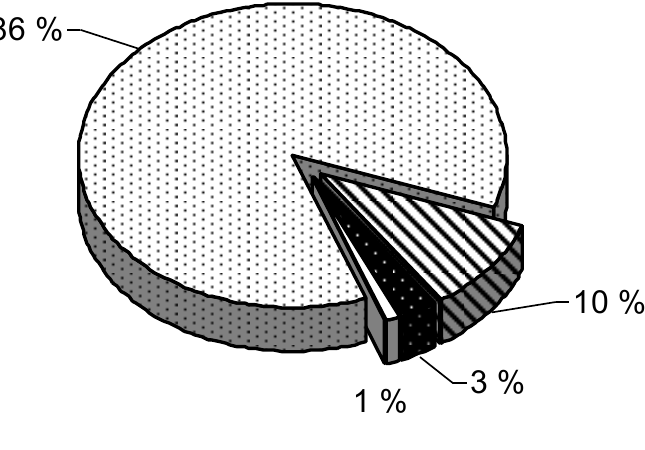
Fig.3. Importance of application of individualized approach in tennis players’ training (by data of questioning n=24):